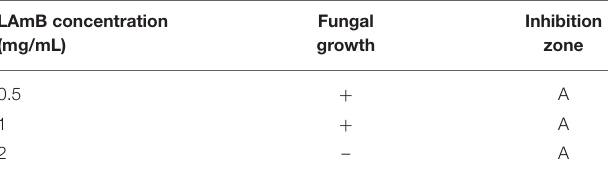
LAmB concentration